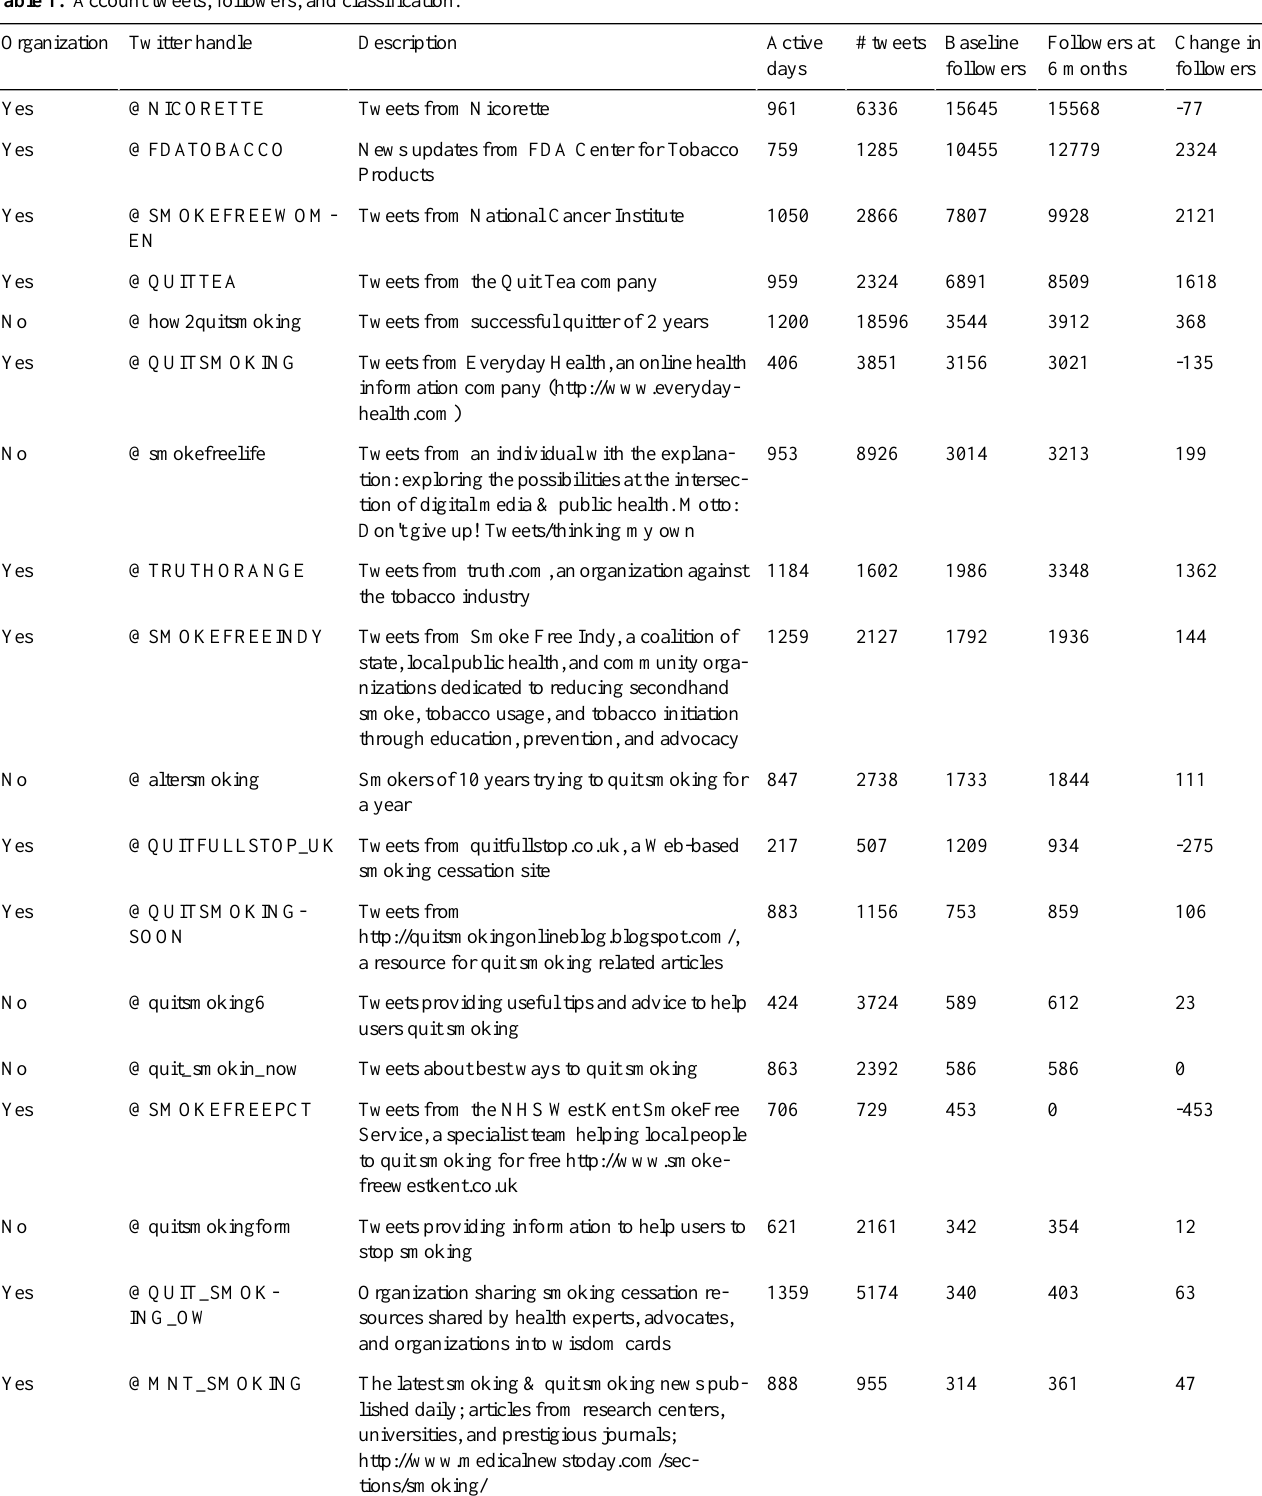
Table 1. Account tweets, followers, and